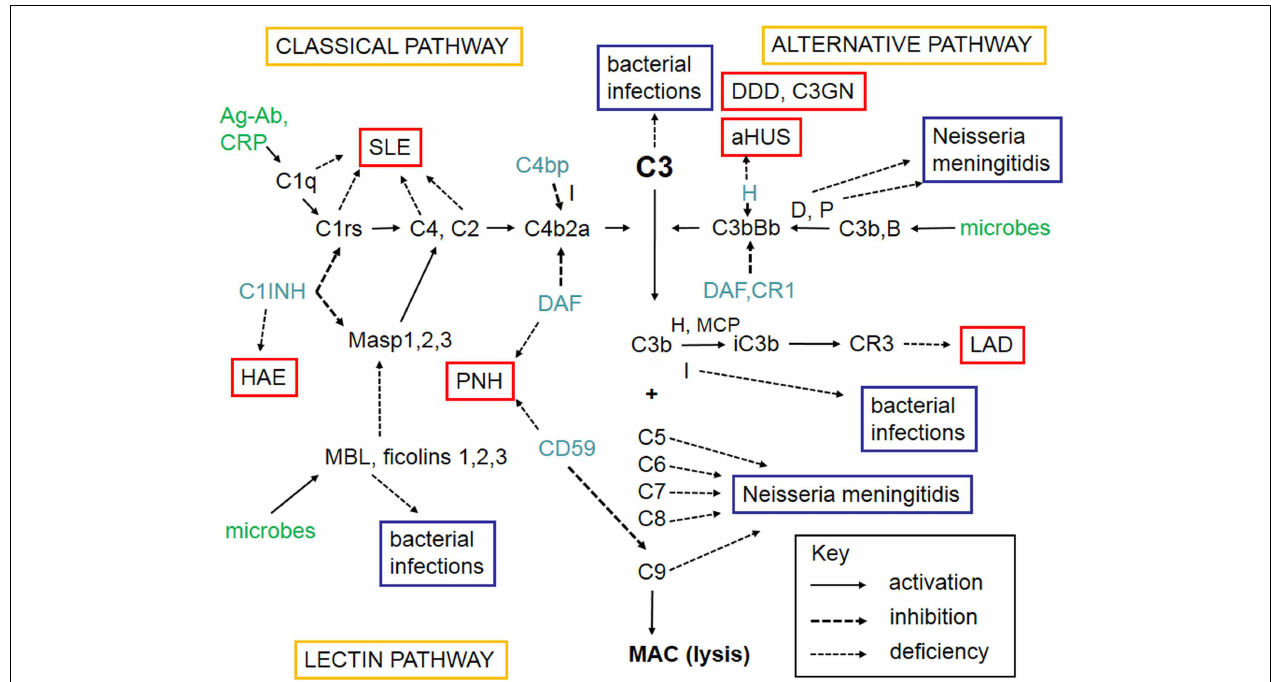
FIGURE 1 |A schematic figure of the complement system .The figure shows the three complement activation pathways (yellow boxes), the components needed for activation (in black, like C3), the targets that activate complement (green), the different complement regulators (blue), and consequences of deficiencies of individual complement components leading either to infections (lilac boxes) or to complement deficiency syndromes (in red boxes). Explanations of the different arrow types are shown in the key box (bottom right).The classical pathway (top left) can be activated by C1q that binds to immune complexes or C-reactive protein.The lectin pathway (bottom left) becomes activated by mannan-binding lectin (MBL) or ficolins that bind to carbohydrates or acetylated moieties.The alternative pathway (top right) becomes activated spontaneously upon interaction with a foreign surface (e.g., microbes) that lacks complement inhibitors. After binding of C1q, MBL, or ficolins to their targets, the serine esterases attached to them (C1r, C1s, MASPs) become activated and cleave the subsequent components C4 and C2. C4b and C2a together generate the classical pathway C3/C5